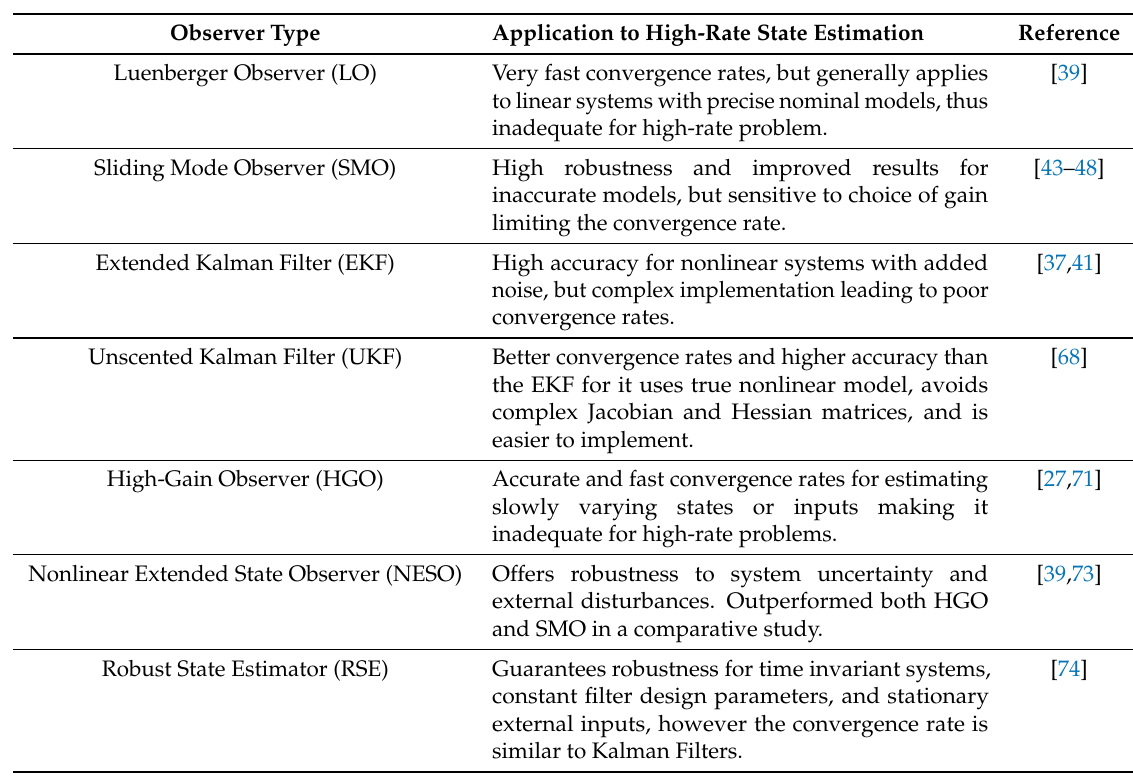
Table 1. Summary of observers in terms of general applicability to the problem of high-rate state